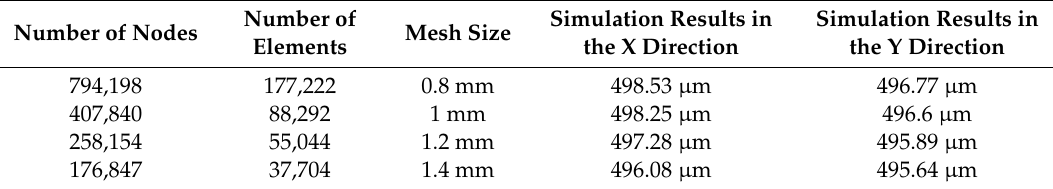
Table 4. The simulation results of the micro-positioning platform in the XY direction under different mesh qualities.